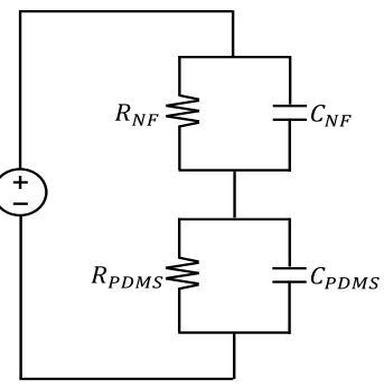
Equivalent electrical circuit of the composite layer used for the derivation of the electric polarization.